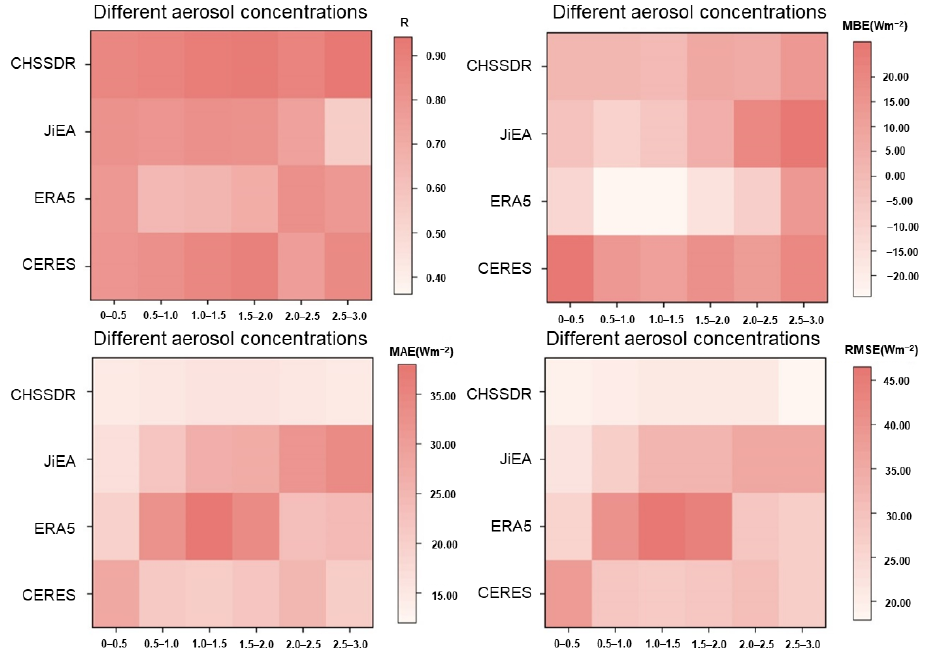
Figure 9. Validation under different aerosol concentrations conditions among surface diffuse solar radiation products.